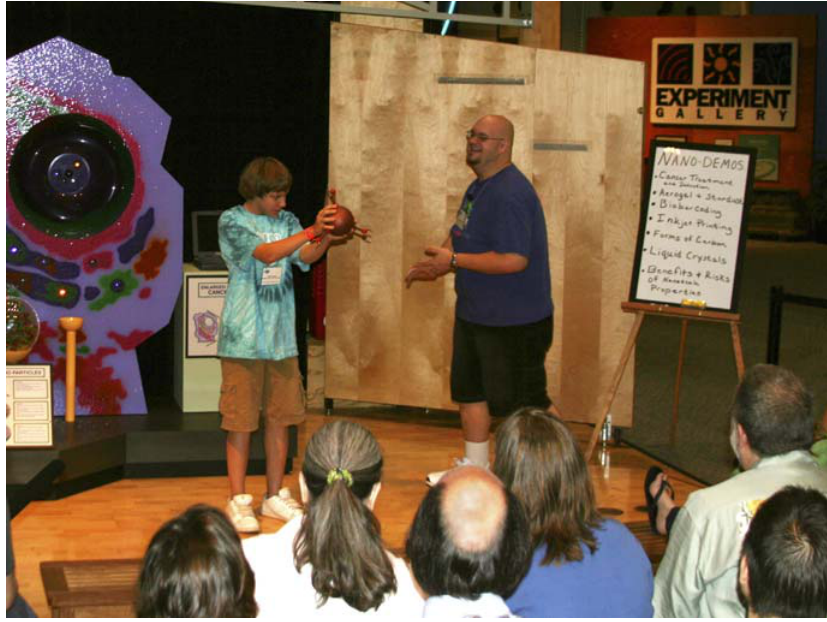
Figure 1. Gallery